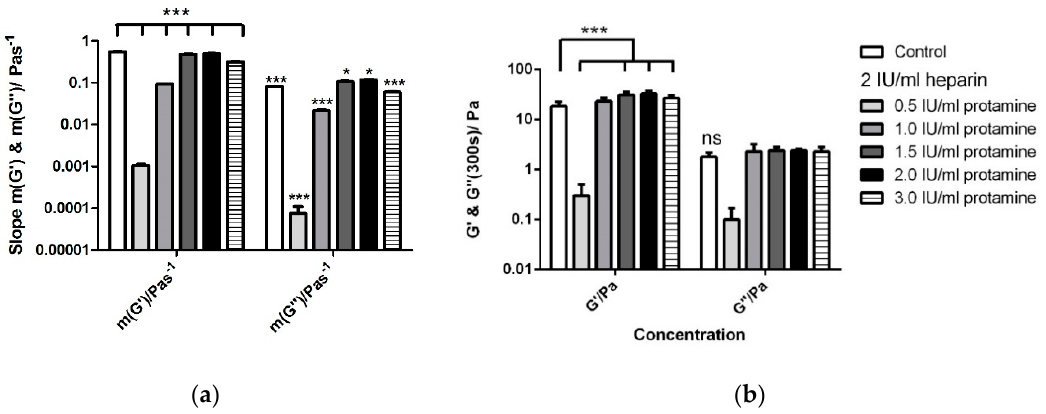
Figure A10. Back titration of heparin with protamine determined by the oscillatory rheometer ( n = 3). The asterics above the bars indicate that this particular bar is significantly different from all others. Citrated blood was heparinised (2.0 IU/mL) and antagonised with various protamine concentrations before activation with Thromborel. Non-heparinised citrated blood activated by Thromborel served as control. ( a ) The mean linear slopes of elastic and viscous shear moduli (±SD) were all significantly different from the non-heparinsed control; ( b ) The elastic shear moduli were significantly different, whereas the visocus shear moduli were not significantly different from the mean control. * p < 0.05, *** p < 0.001.